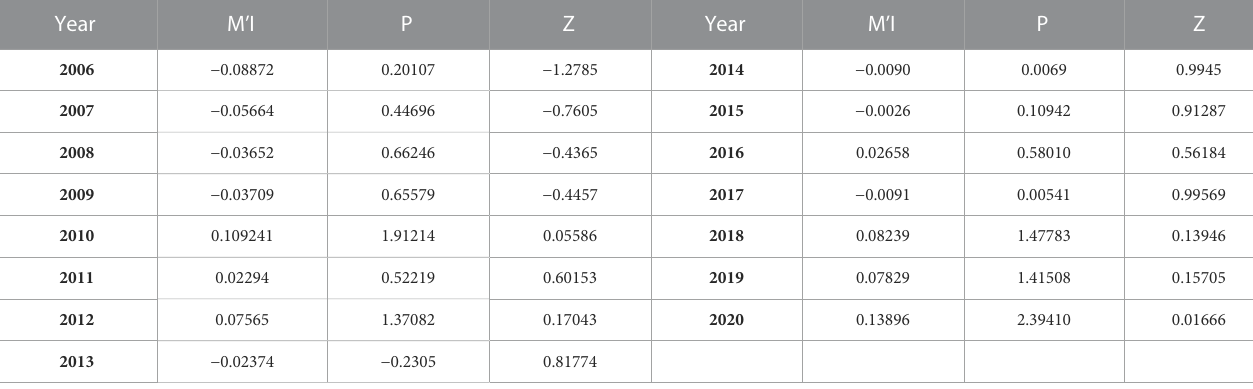
TABLE 2 ULUE global Moran ’ s I value of the